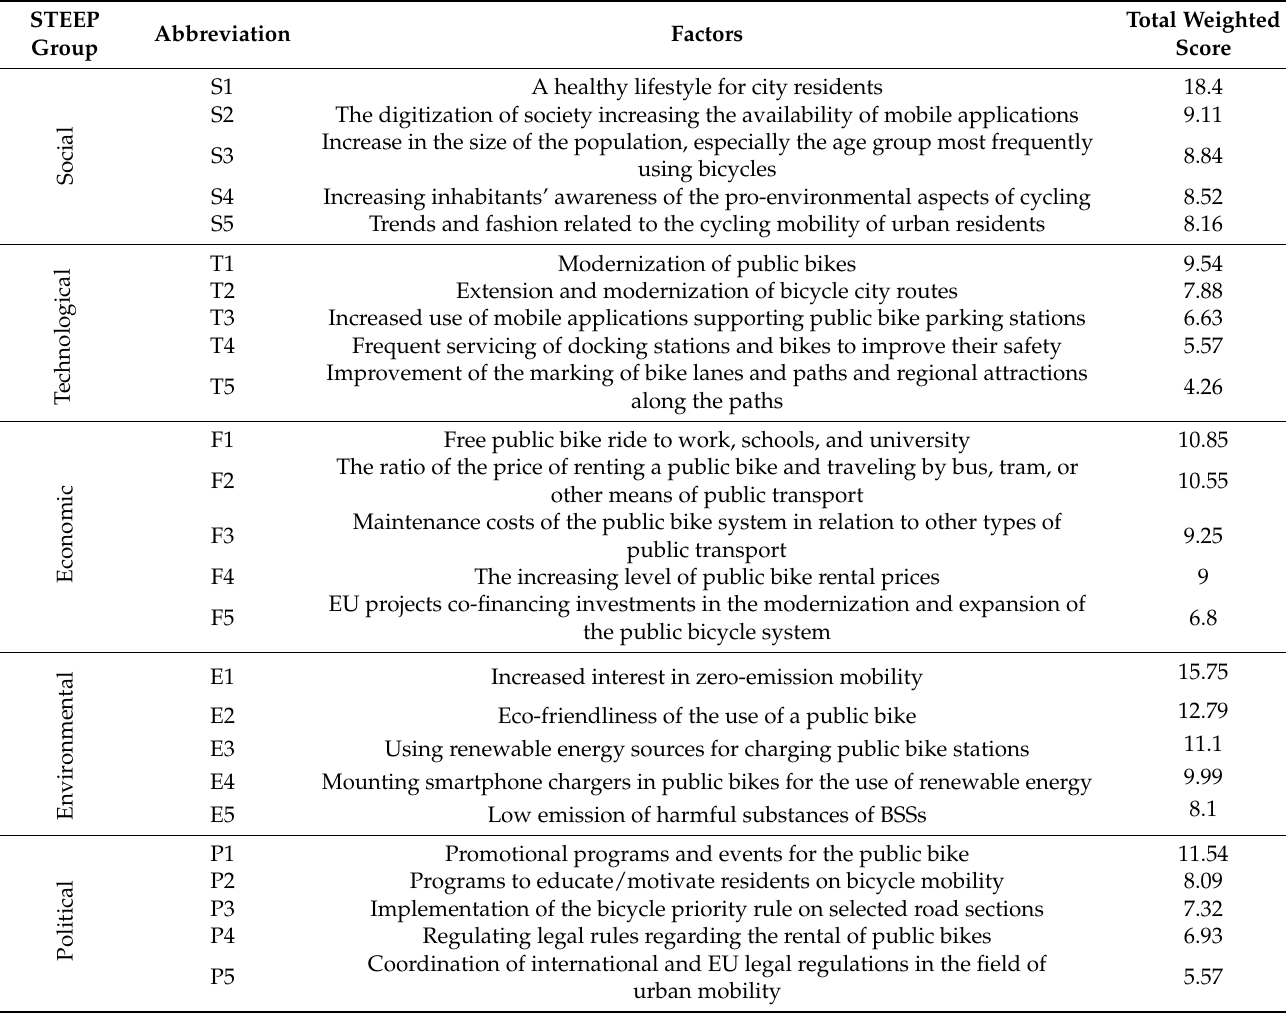
Table 2. Key STEEP factors influencing the